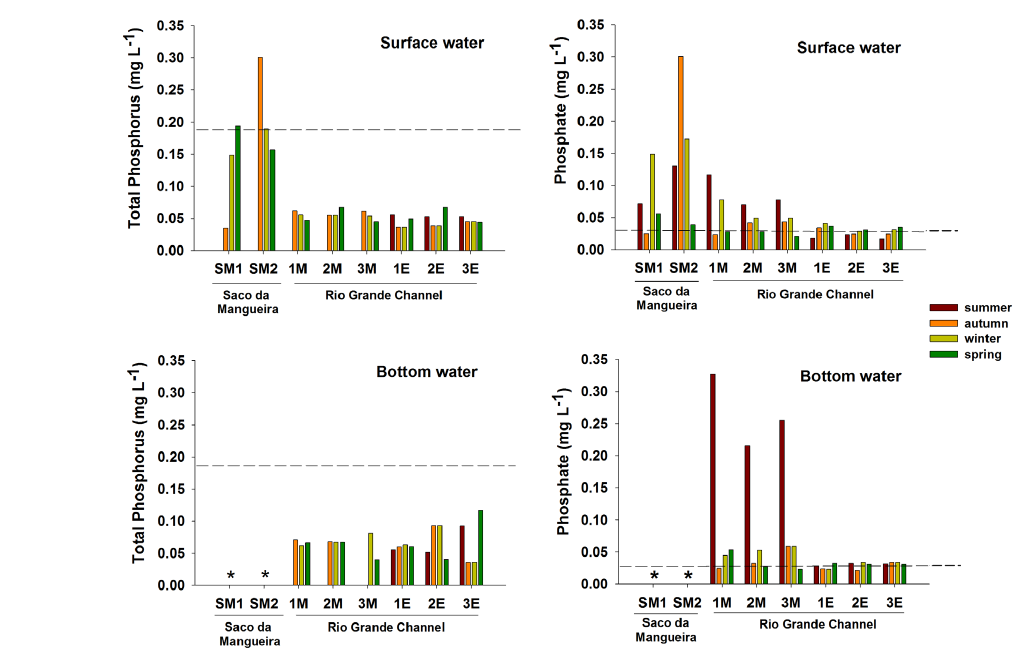
Figure 2. Seasonal variation of total phosphorus and phosphate (mg.L -1 ) at the margin of the Saco da Mangueira (sites SM1 and SM2) and in the Rio Grande Channel at the margin (sites 1M, 2M and 3M) and in the channel (sites 1E, 2E and 3E sites) in 2011. Dashed lines: reference values of 0.186 mg.L -1 for total phosphorus (CONAMA, 2005) and 0.031 mg.L -1 for phosphate (Aminot & Chaussepied, 1983). * Data are absent because of the low depth in the